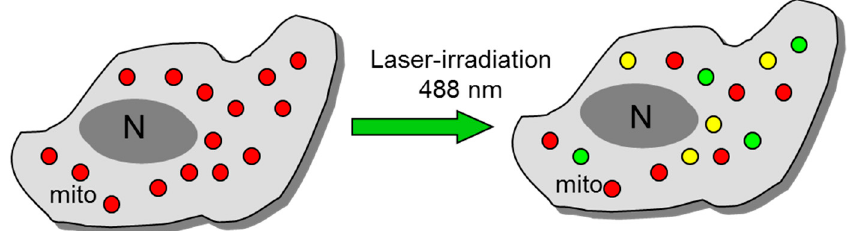
Figure 5. LaserirradiationasatoolformitochondrialproductionofROS.Noteasignificantheterogeneityof Figure 5. Laser irradiation as a tool for mitochondrial production of ROS. Note a significant mitochondriainthecellinrelationtomitoROSlevelsanddegreesofmitochondrialdepolarization(declinein heterogeneity of mitochondria in the cell in relation to mitoROS levels and degrees of mitochondrial the inner-membrane potential). mitoROS were visualized with 2,7-dihydrodichlorofluorescein (DCF) by depolarization (decline in the inner-membrane potential). mitoROS were visualized with 2,7- 488 nm laser irradiation. Mitochondrial membrane potential was monitored with tetramethylrhodamine dihydrodichlorofluorescein (DCF) by 488 nm laser irradiation. Mitochondrial membrane potential methyl ester (TMRM) by simultaneous 543 nm laser was monitored with tetramethylrhodamine methyl ester (TMRM) by simultaneous 543 nm laser irradiation.